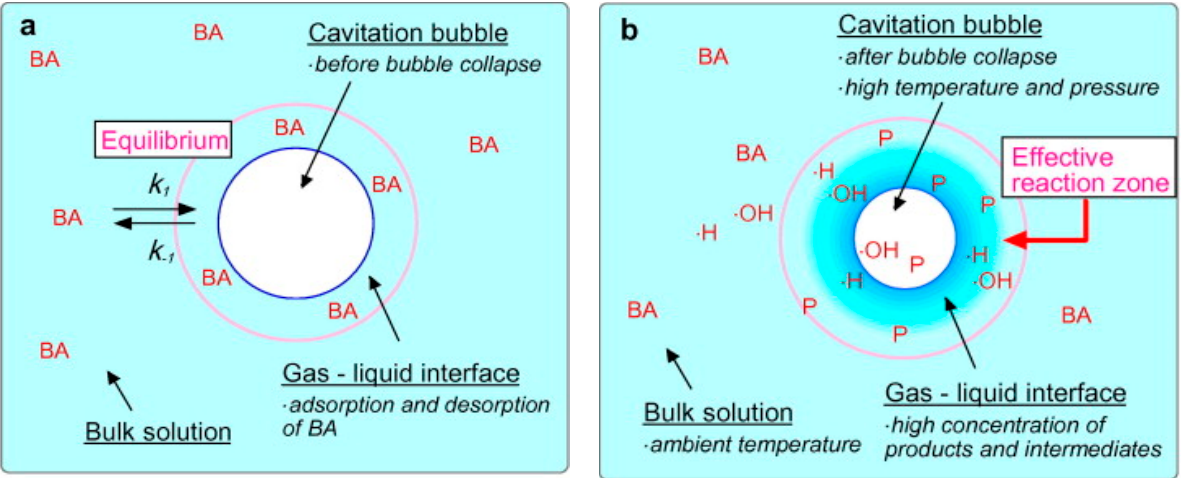
Figure 5. ( a ) Gas–liquid interface before bubble collapse, and ( b ) sonolysis of butyric acid after bubble collapse. P, products or intermediates (adapted from [110]).